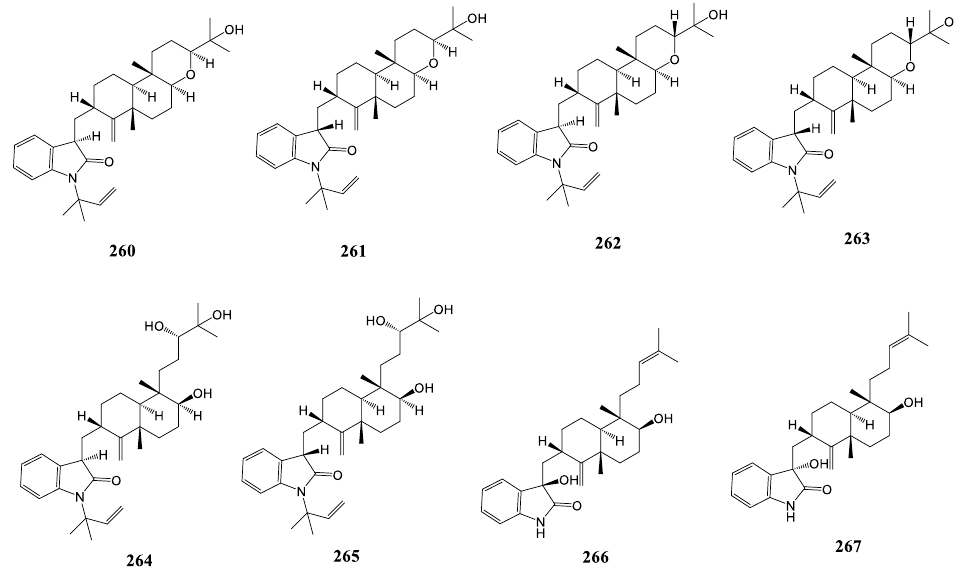
Figure 14. Structures of anthcolorin indole diterpenes.